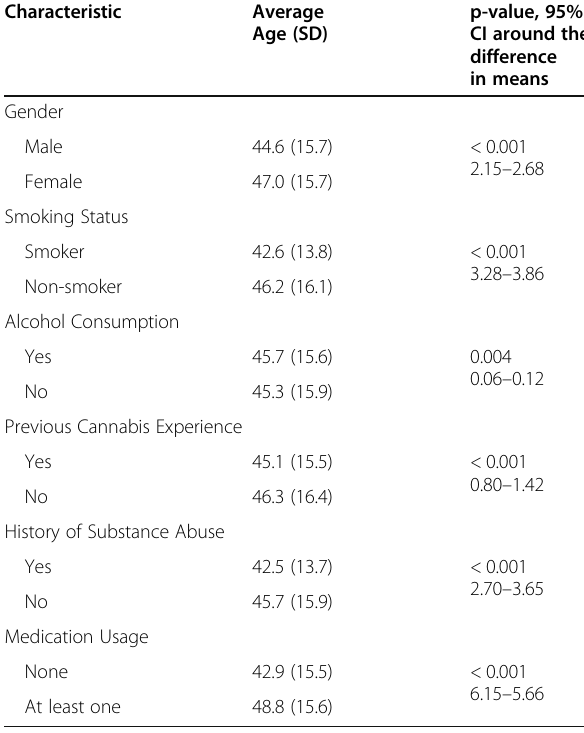
Table 2 summarizes the analysis of differences of key patient characteristics by age. T-tests were conducted for differences in average age for all characteristics. SD standard deviation, CI confidence interval. CIs are provided around the differences in the means